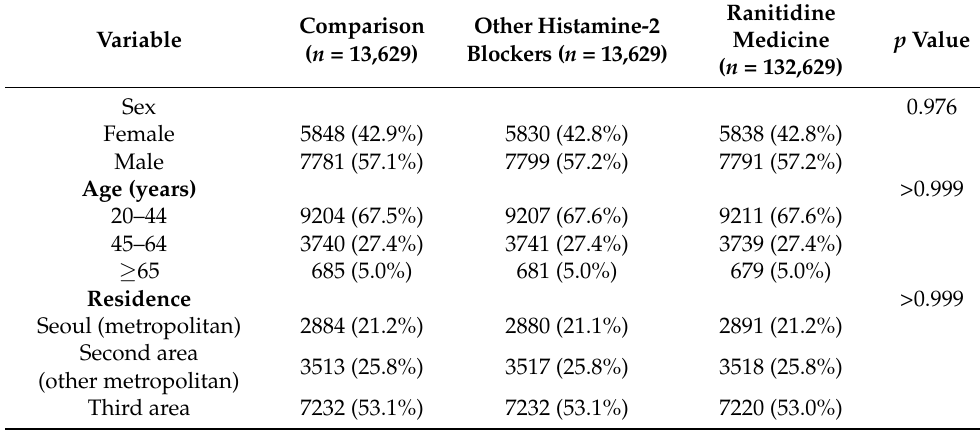
Table 1. Characteristics of the study